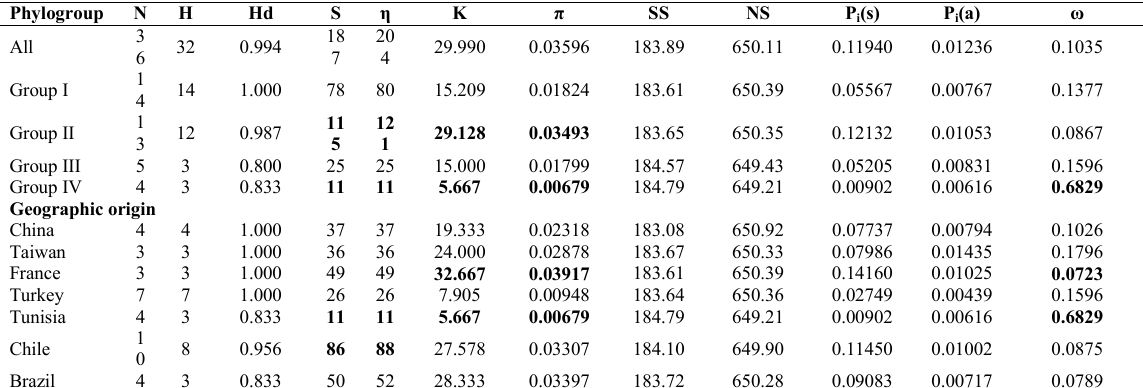
Table 2. Genetic variation and polymorphism analysis of LMV CP from different populations. Phylogroup